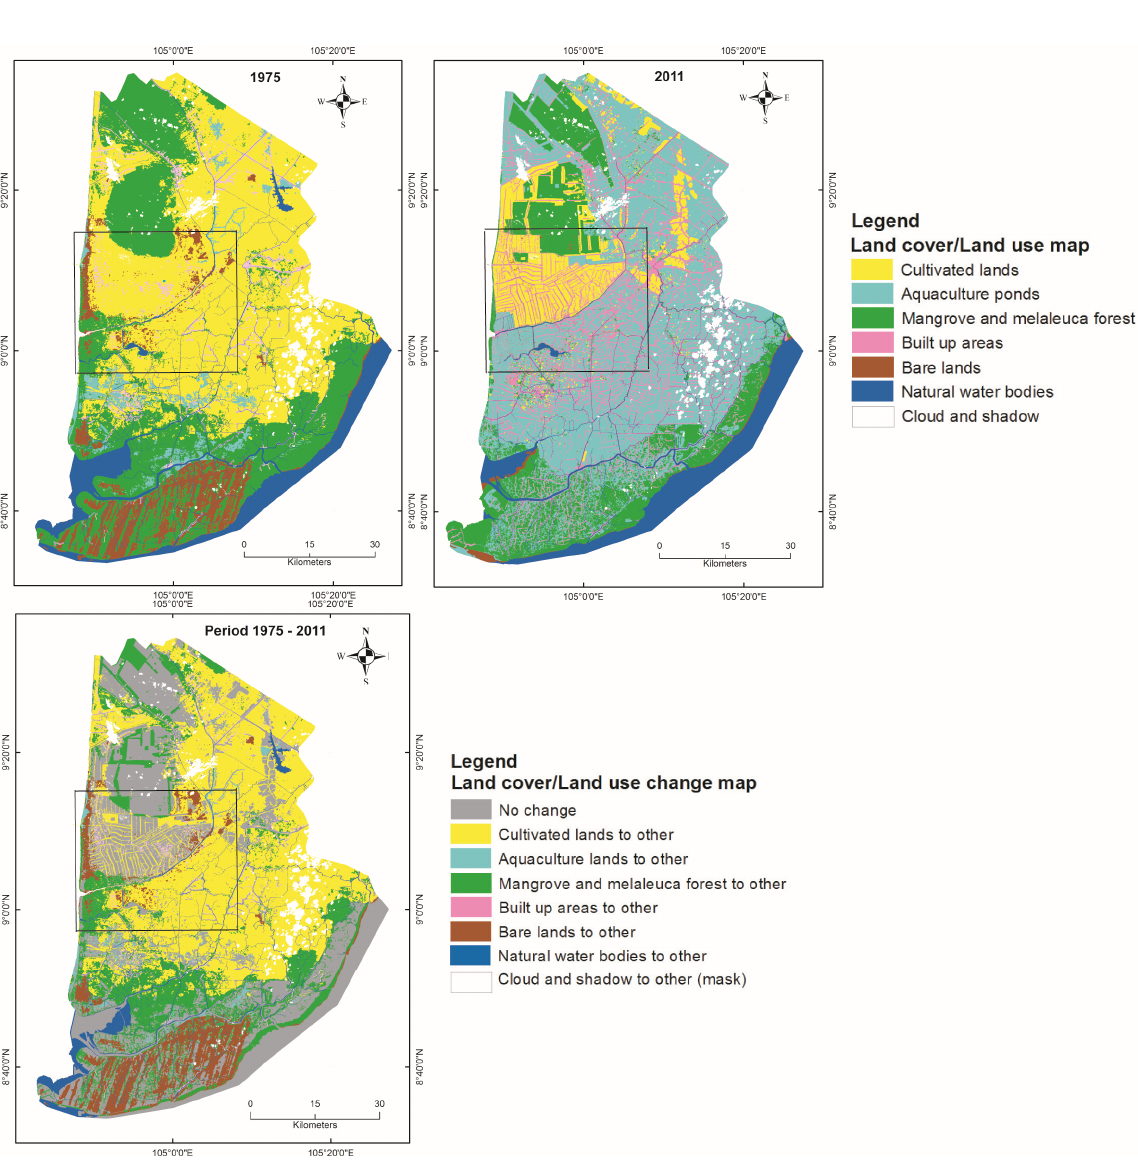
Figure 5. Land use/land cover and change detection of Ca Mau Province in period 1975 and 2011. Black square indicate the localization of the Tran Van Thoi District analyzed in more details in the study. Table 2. Accuracy assessment statistics of land cover/land use classification in percent (Abbreviation Cultivated lands: Cu; Aquaculture ponds: Aq; Mangrove forest: